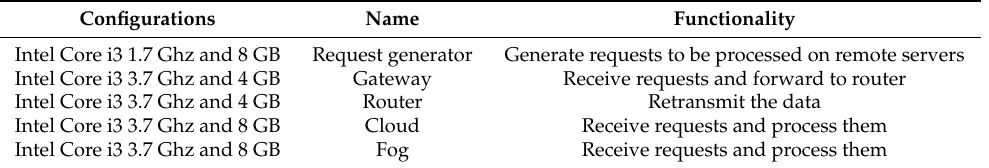
Figure 8. Practical experiment outline. Table 3. Machines’ configuration.